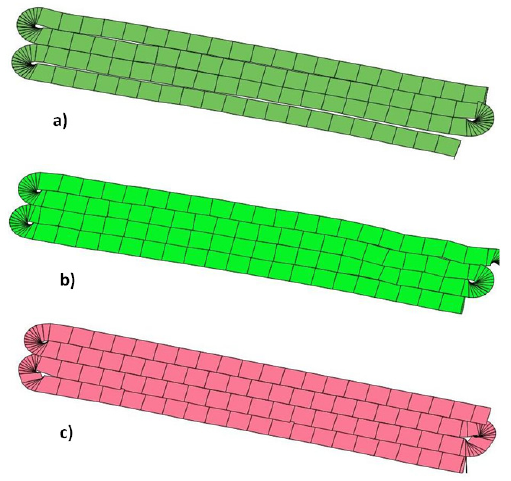
Figure 4. Operation crop weed control: GIS display in manual ( a ), assisted ( b ), and automatic guide ( c ).